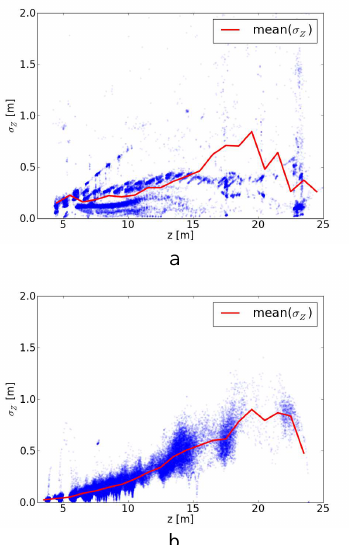
Figure 9. Standard deviation of the depth: a) gray-coded image, b) histogram.